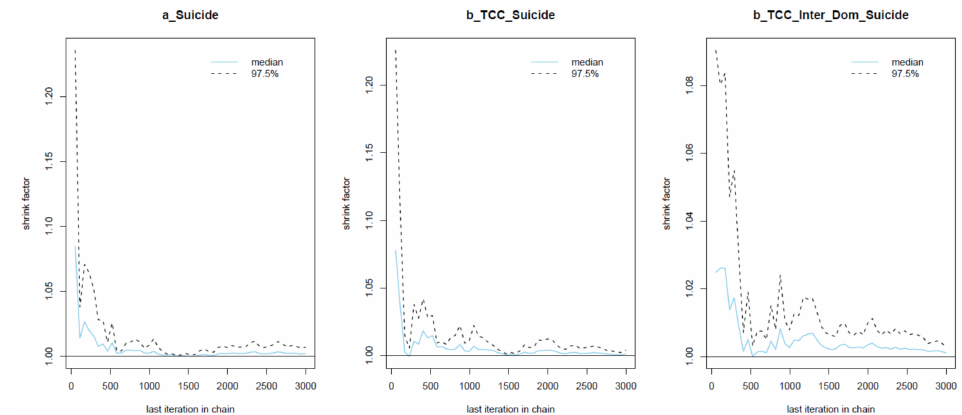
Figure A1. Gelman plots for Model 1 (cid:48) s posterior coefficients.